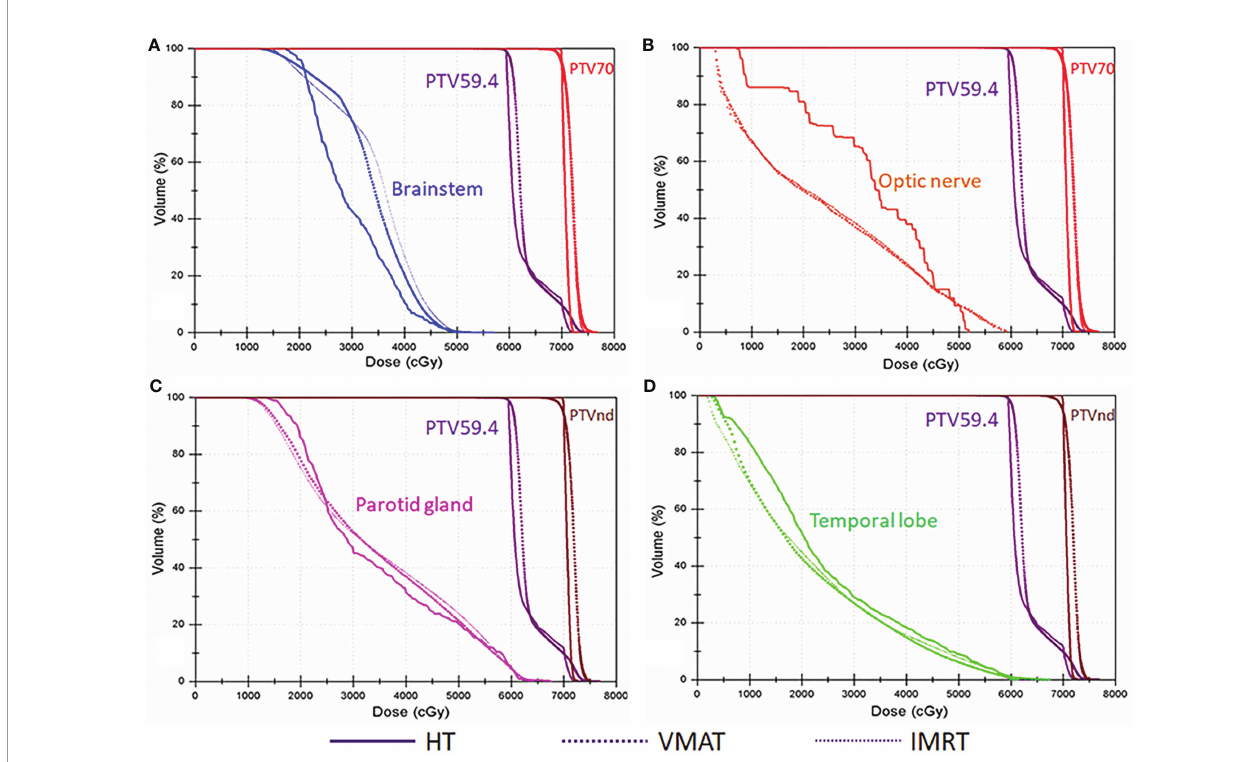
FIGURE 3 | Typical dose – volume histograms for the three plans in locally advanced nasopharyngeal carcinoma (NPC). Dose – volume histograms for planning target volume of 70 Gy (PTV 70 ; red), planning target volume for metastatic lymph nodes (PTV nd ; brown), planning target volume of 59.4 Gy (PTV 59.4 ; purple), (A) the brainstem (blue), (B) optic nerve (orange), (C) parotid gland (pink), and (D) temporal lobe